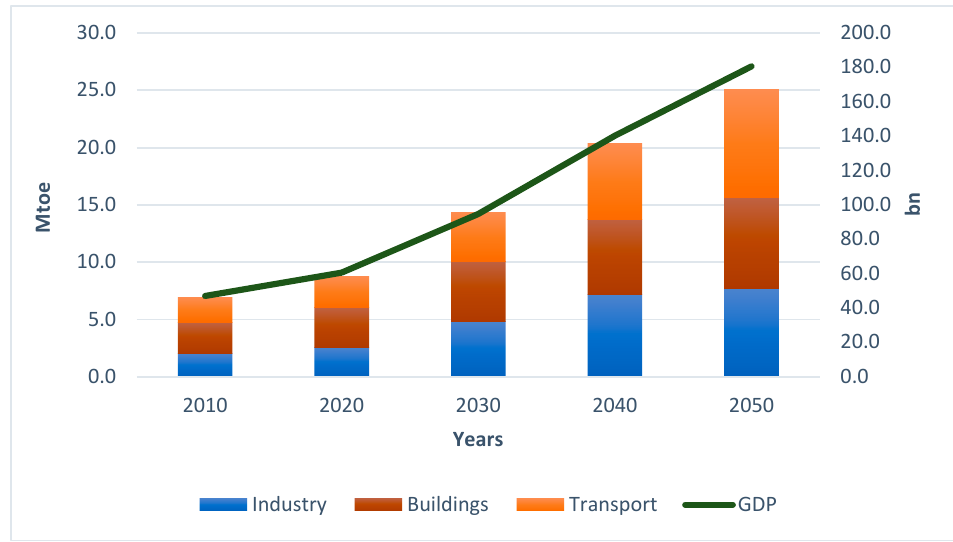
Figure 4. Sectoral split of final energy consumption (Mtoe) in Tunisia (left axis) and GDP (bn) evolution (right axis), over 2010–2050 (BAU scenario). Source: MENA-EDS Model (BAU scenario )